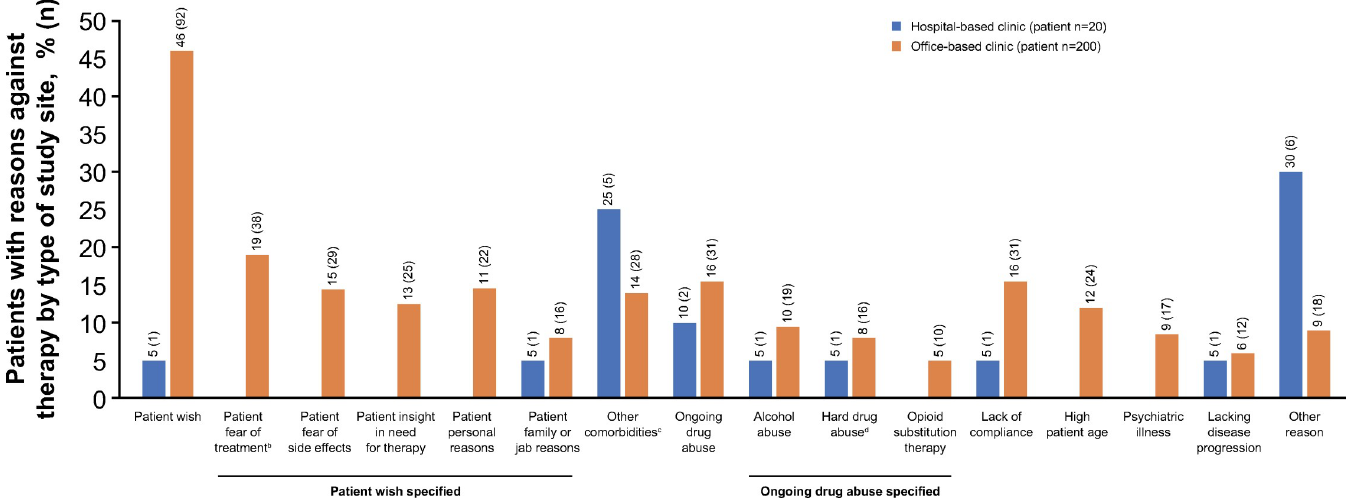
Fig 3. Reasons ( > 4% patients) for not initiating treatment by type of study site a . a Multiple selections were allowed; b Fear of treatment consisted of intrinsic anxiety related to treatment, eg, loss of control, disruption of daily activities, etc; c Include decompensated disease, coronary heart disease, diabetes, skin disorders, immunological-inflammatory disorder, neurological disorder, and human immunodeficiency coinfection; d Heroine, amphetamine, cocaine, designer drugs (or none of these